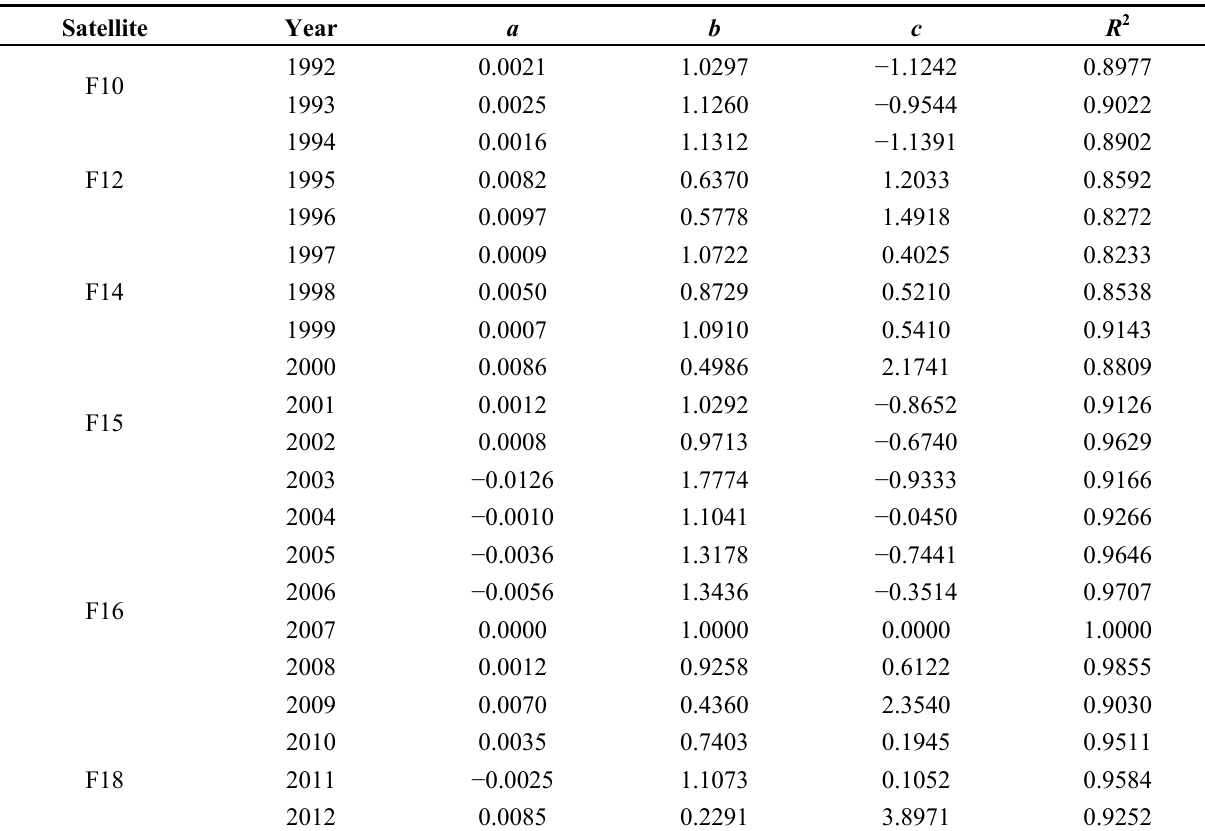
Table 1. Coefficients of the second order regression